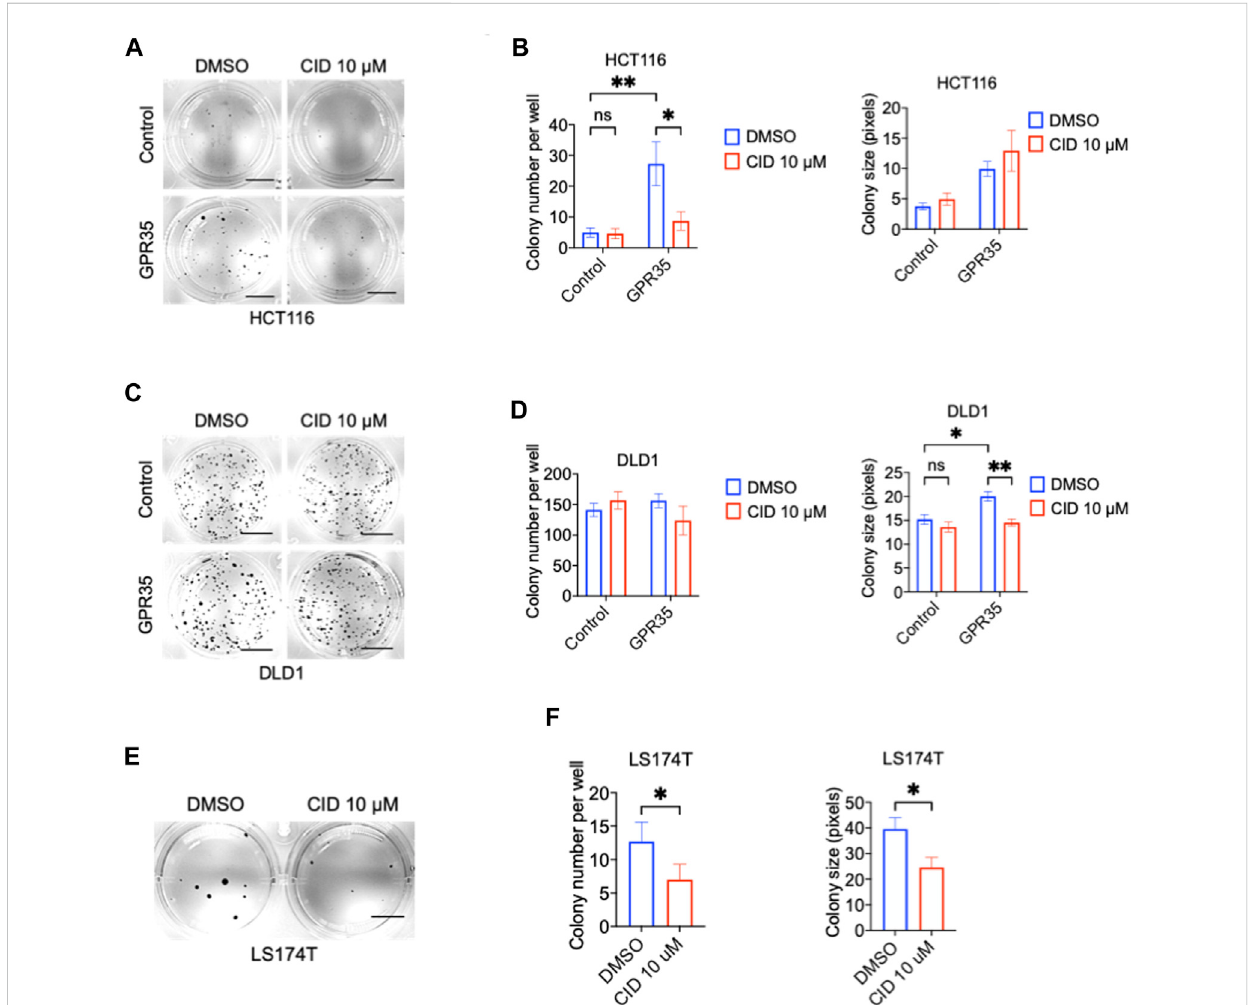
FIGURE 2 CID-2745687 attenuated anchorage-independent cell growth in GPR35-expressing CRC cells. (A,B) Representative images of colonies formed by HCT116celllinesinsoftagarin21 daysandquanti fi cationdataofsoftagarcolonyformationassay( n =3).Scalebars:0.5 cm. (C,D) Representativeimages of colonies formed by DLD1 cell lines in soft agar in 2 days, and quanti fi cation data of soft agar colony formation assay ( n = 3). Scale bars: 0.5 cm. (E,F) RepresentativeimagesofcoloniesformedbyLS174Tcelllinesinsoftagarin21 days,andquanti fi cationdataofsoftagarcolonyformationassay( n = 3). Scale bars: 0.5 cm. Cells were suspended in a medium with 10 μ M CID and seeded in soft agar. The medium was refreshed, and 10 μ M of CID was added every 3